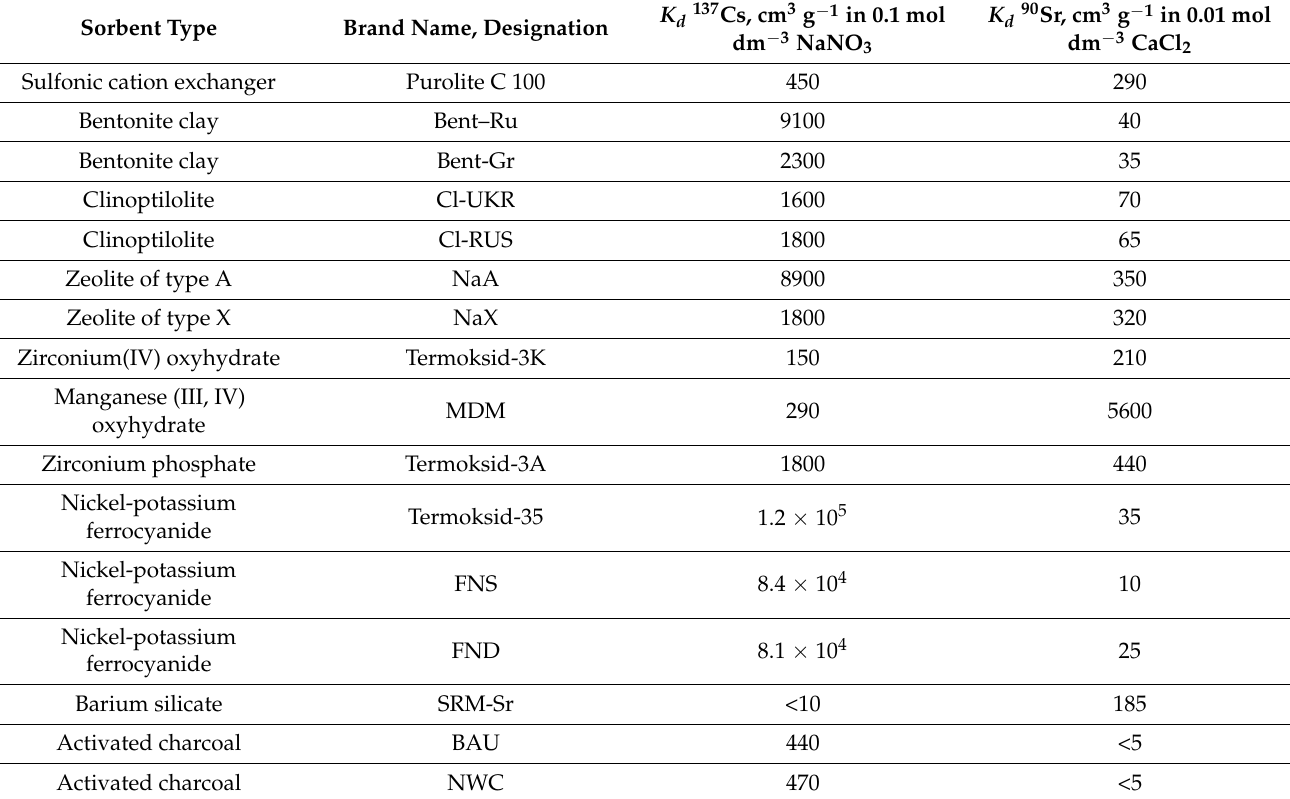
Table 1. The distribution coefficient (K d ) values for 137 Cs and 90 Sr on different sorbent